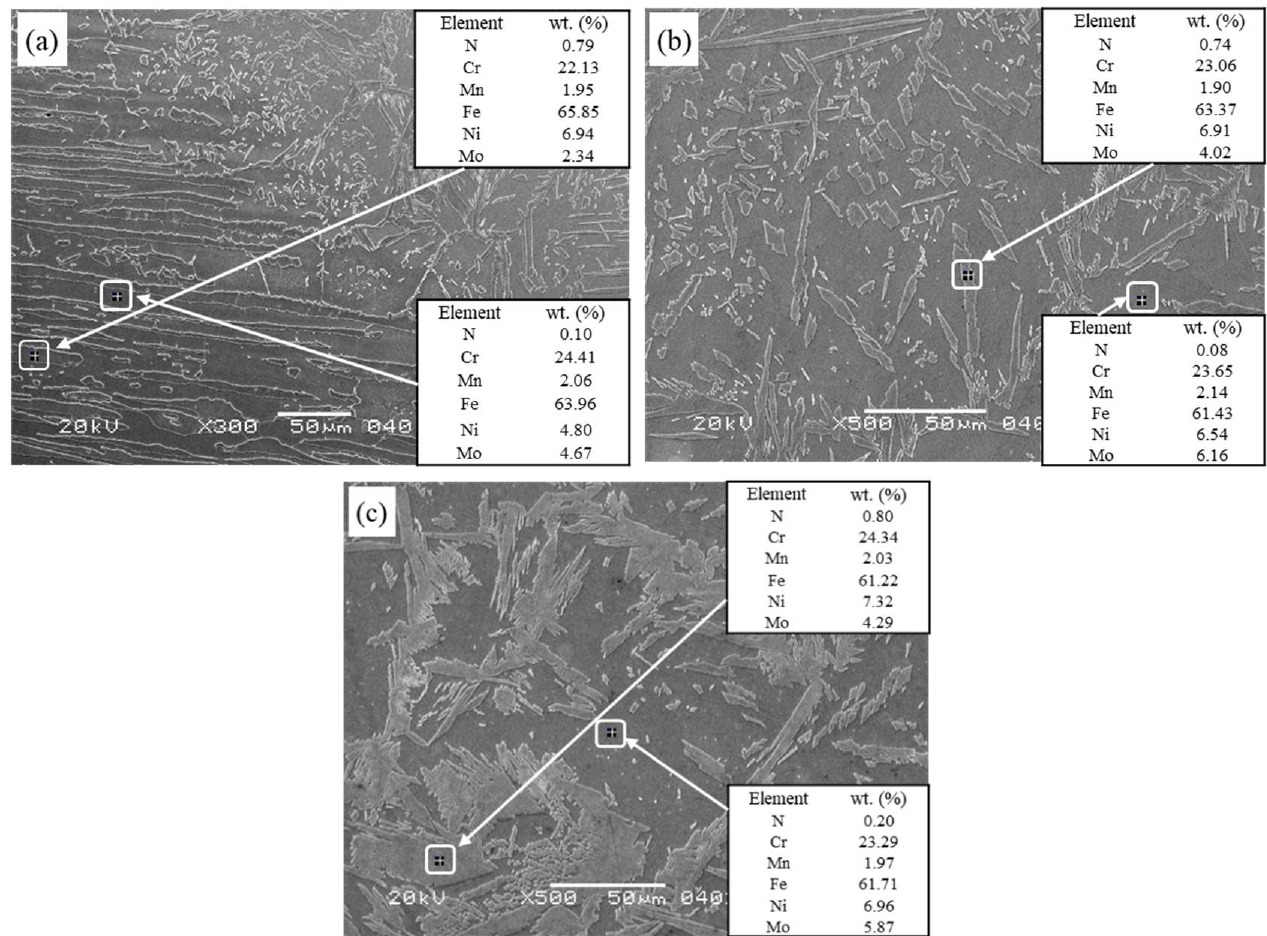
Figure 5. SEM and EDS analysis resulted in different welded joints. ( a ) BM and HAZ; ( b ) WM 0 mT; ( c ) WM 20 mT. Table 3. Mass percentage (%) of each element in austenite and ferrite in different areas of welded joints.